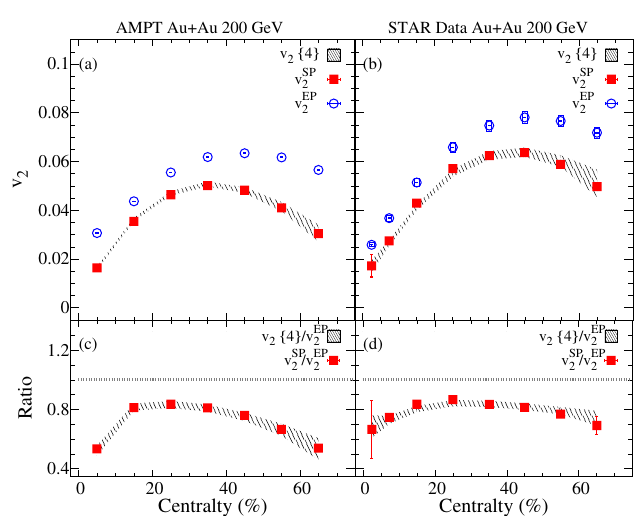
Figure 1. The charged particles centrality dependence of v SP elliptic flow (hashed band) for Au+Au collisions at (AMPT) model panel ( a ). The charged particles centrality dependence of v SP v 2 { 4 } for Au+Au collisions at flow fluctuations represented by the ratios v SP